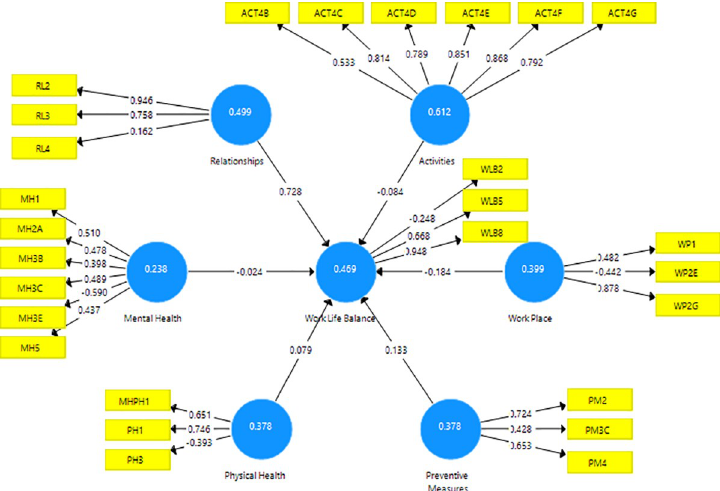
Fig 1. Path coefficients and outer loadings for the direct relationship between the influencing factors and work- life balance.